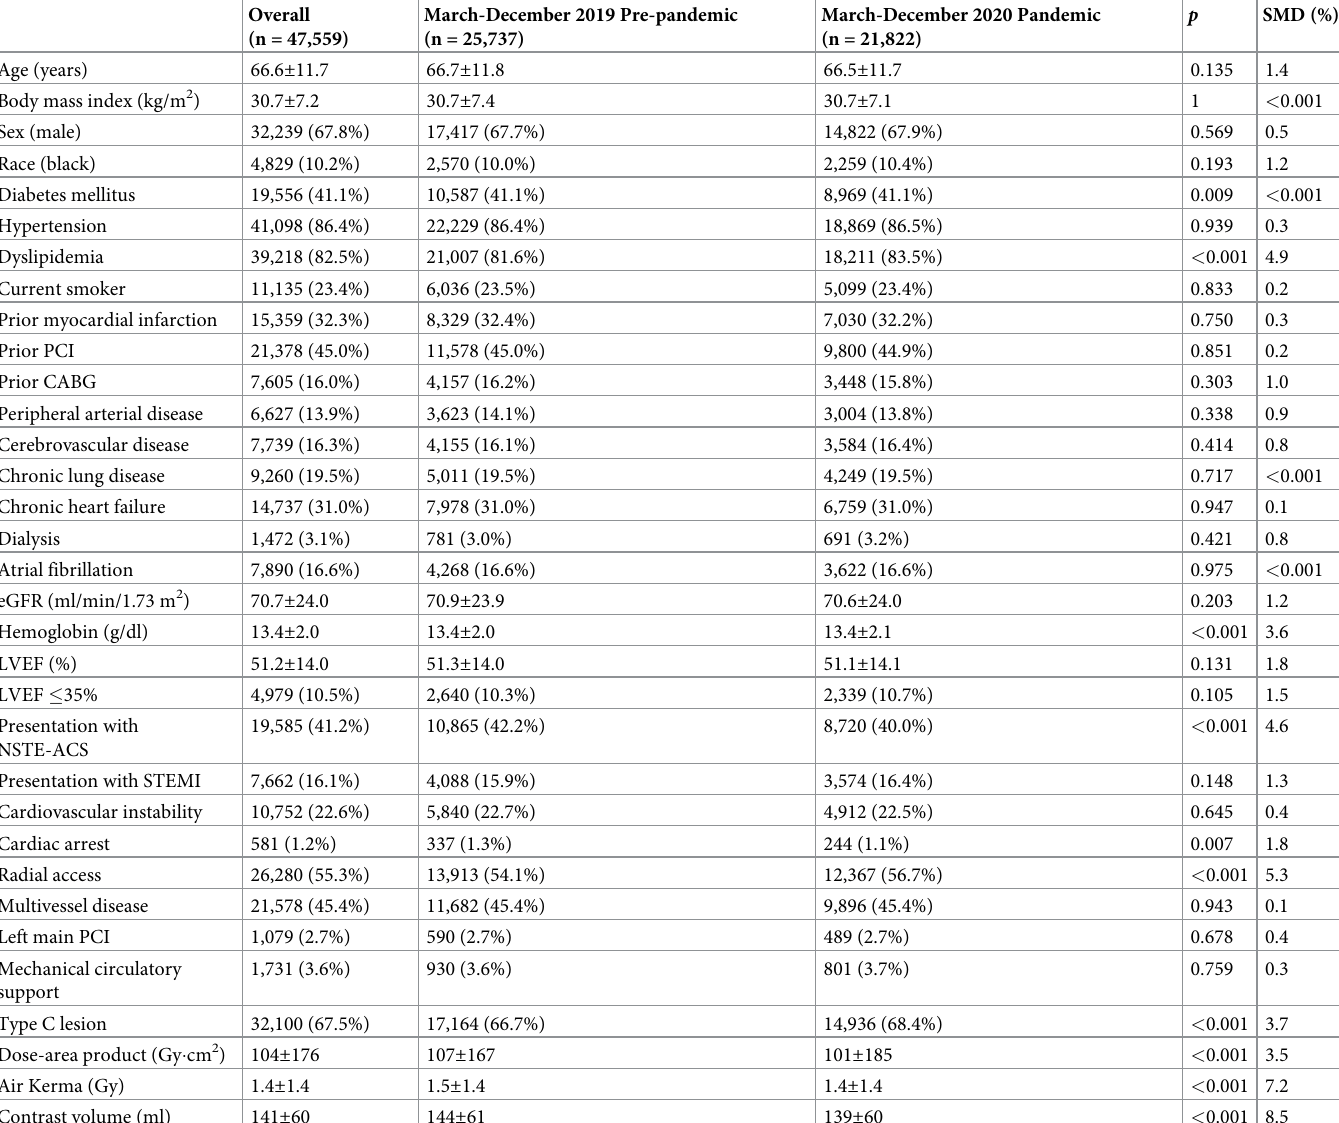
Table 1. Clinical and procedural characteristics in the overall population.